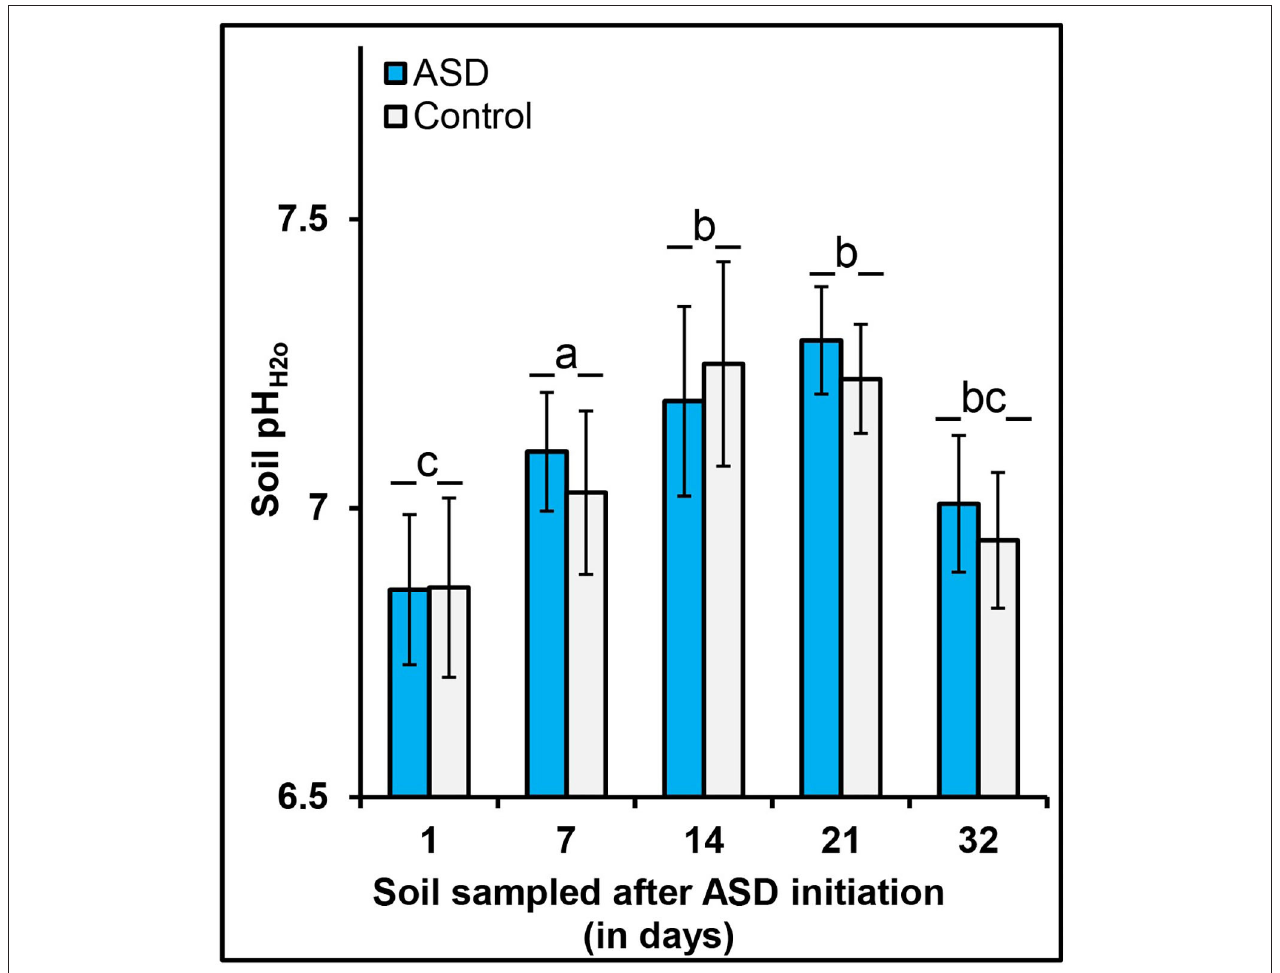
FIGURE 1 | Effect of ASD treatment and sampling time on soil pH, high tunnel, trial 3. Bars indicated by similar letters for sampling time are not significantly different at P < 0.05 according to Fisher’s protected LSD test. Error bars indicate standard error with 12 total replicates (6 replicates × 2 experiments).